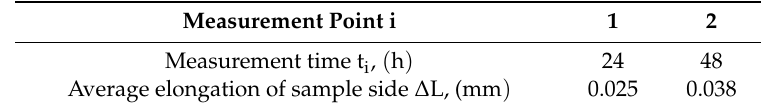
Table 5. Calculation parameters to determine the slope and the intercept in the simple regression S1.